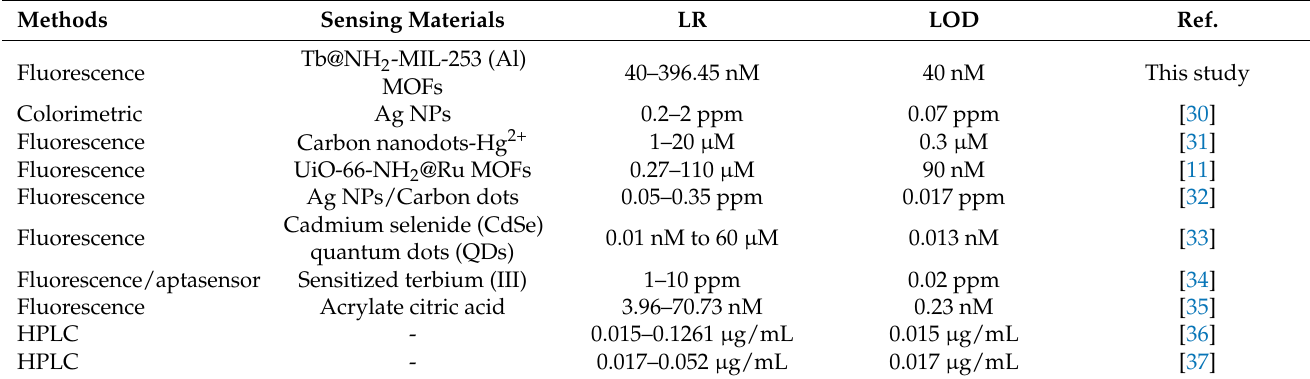
Table 1. The comparison of reported sensing systems for the detection of